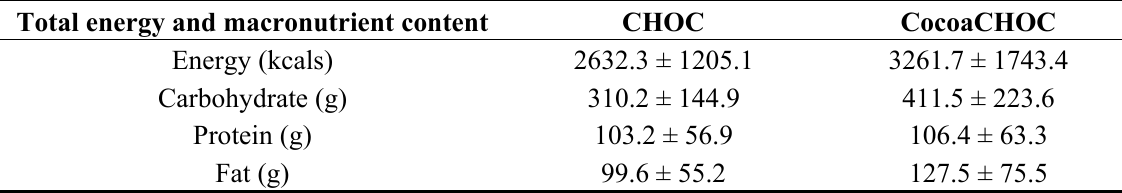
Table 2. Average daily dietary intake for each trial ( n = 8).